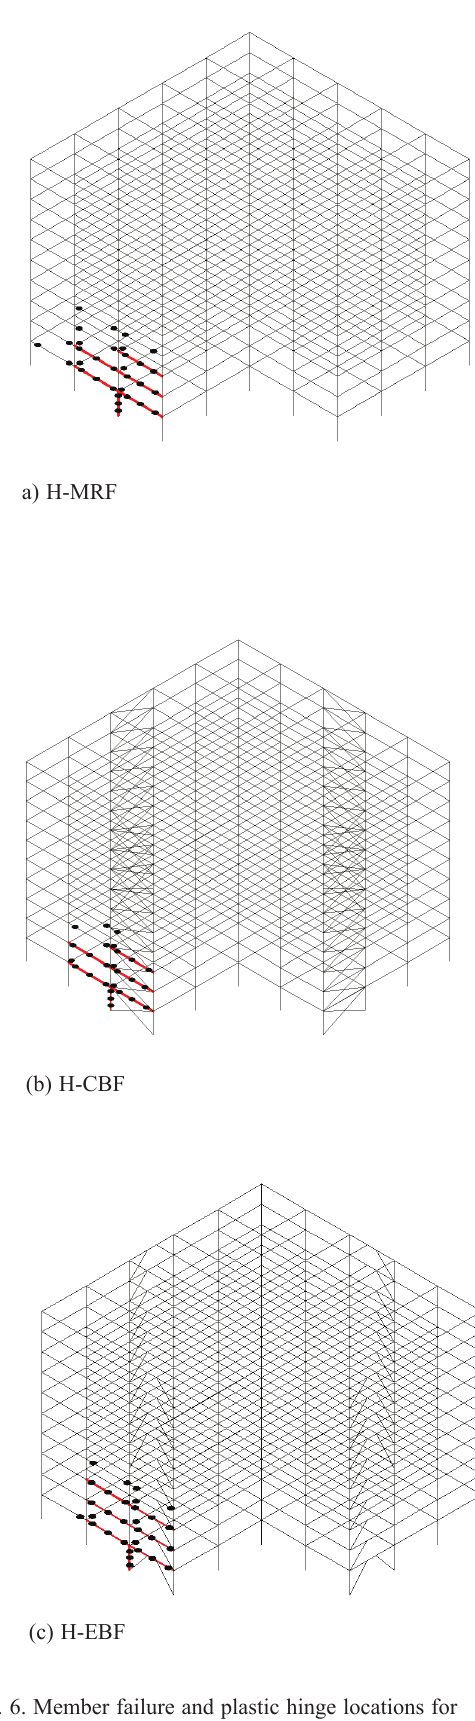
Fig. 6. Member failure and plastic hinge locations for horizontally irregular MRF, CBF, EBF – Blast Location